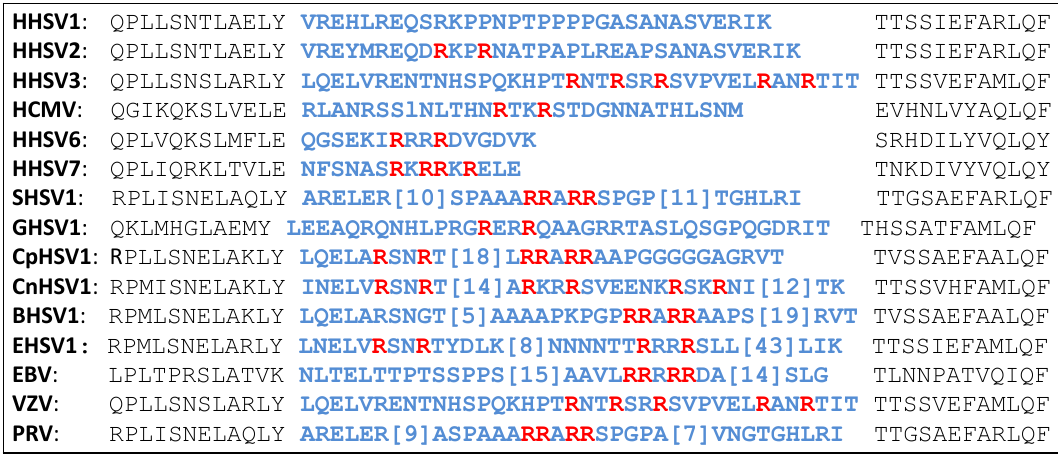
Table 3 . PC cleavage site motifs in the glycoprotein B of herpes viruses. A